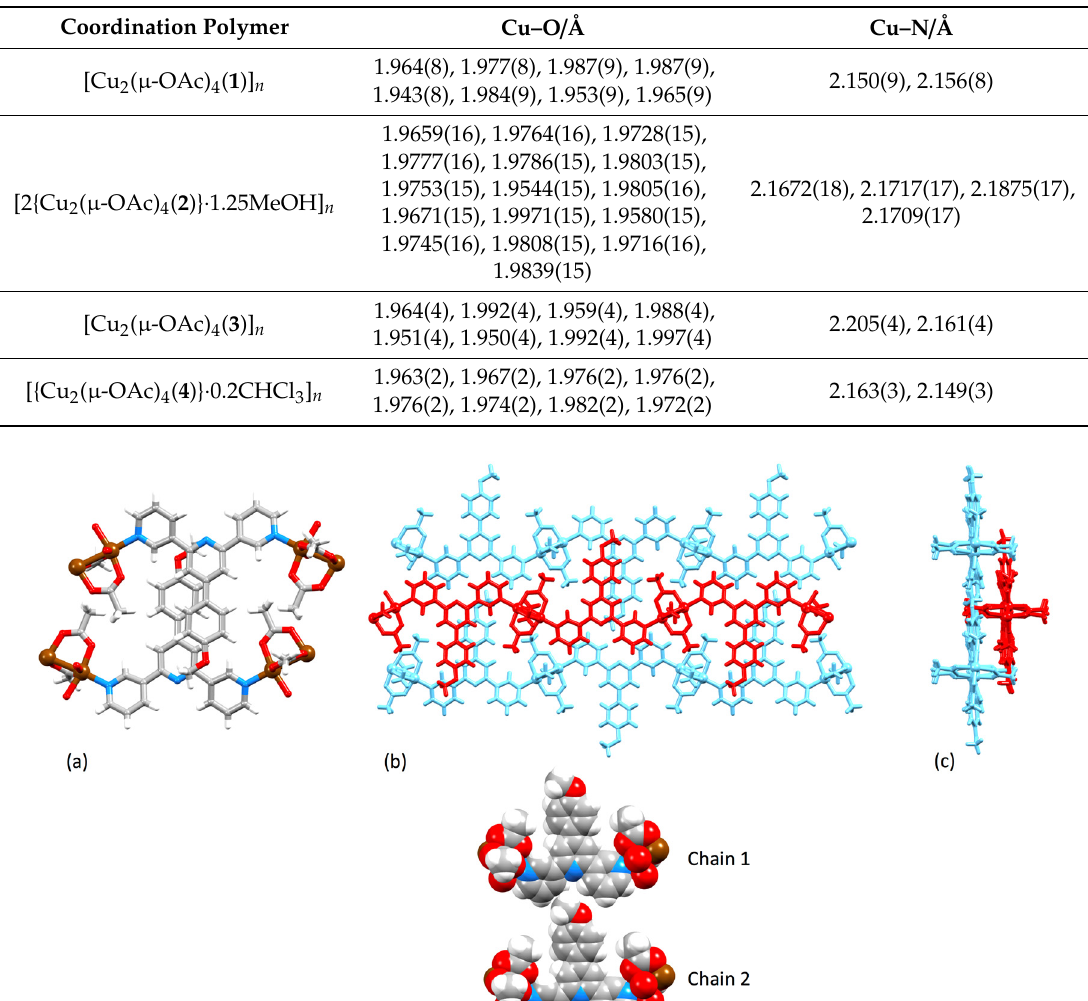
Table 1. Selected bond lengths in the {Cu 2 ( µ -OAc) 4 }-containing coordination polymers. Coordination Polymer